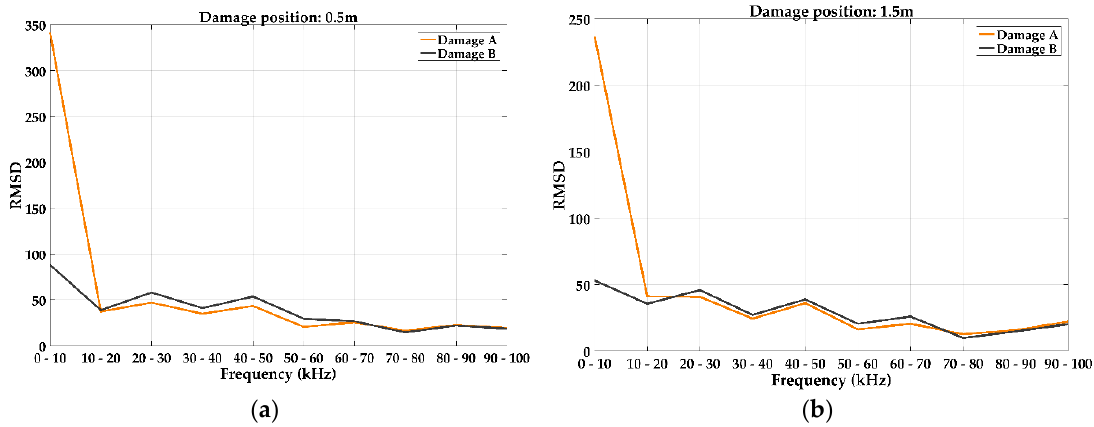
Figure 4. RMSD index for the 0.5 m ( a ) and 1.5 m ( b ) positions relative to the